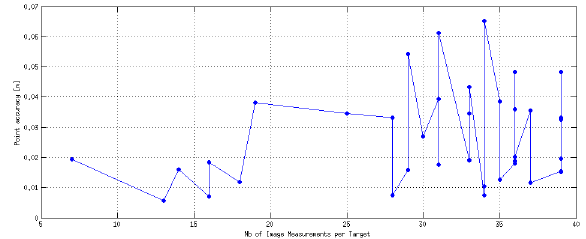
Figure 11: Mean evaluation target track length. A larger number of image measurements has not necessarily a positive effect on the achievable accuracy. The graph looks uniformly distributed or rather oscillating.